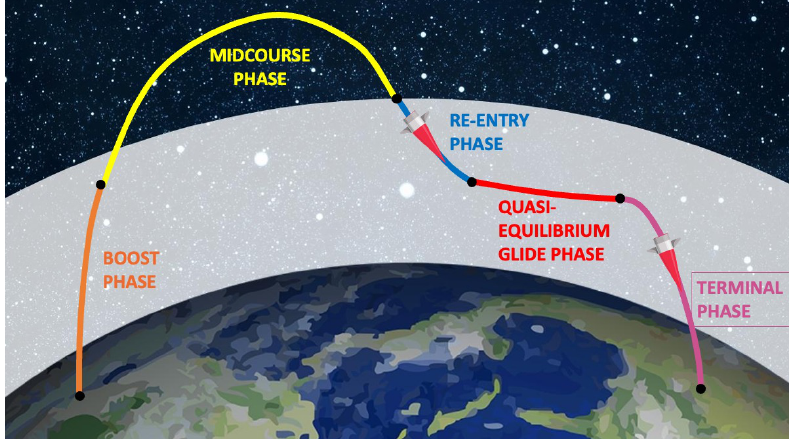
Figure 3. The trajectory of a Maneuverable Reentry Vehicle